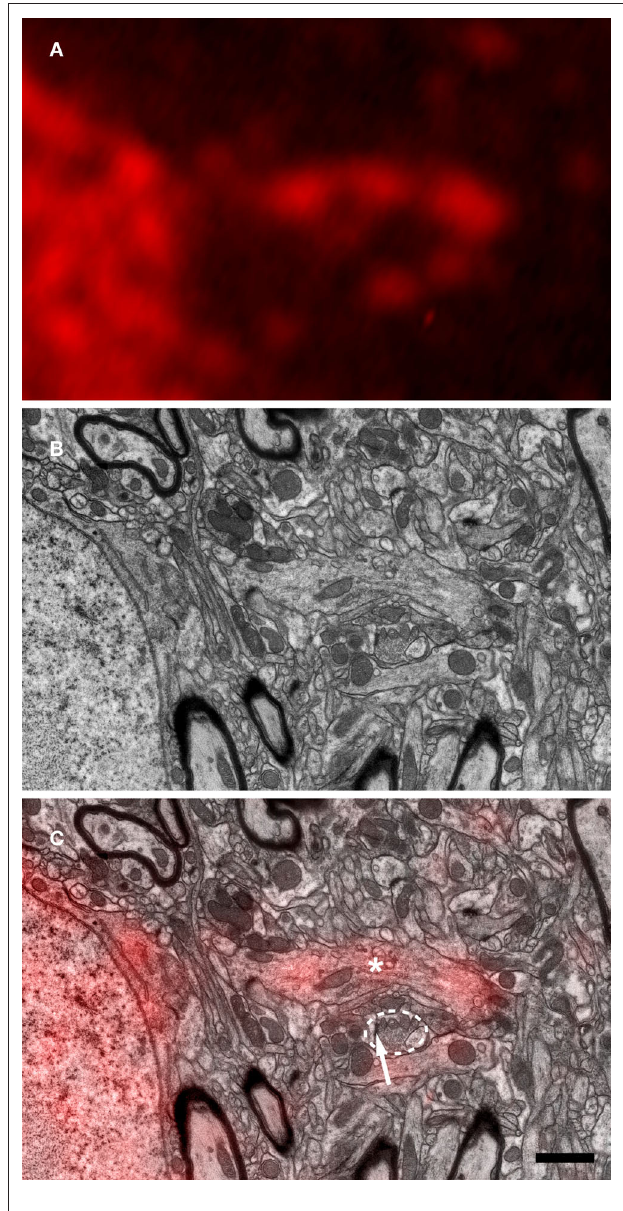
Figure 5 | Magnified view of part of Figure 4. (A) LM image of a dendrite immunostained for Lucifer yellow. (B) TEM micrograph of the same region as in (A) . (C) Superposition of immunofluorescence and TEM images allows classification of the dendrite (asterisk) as belonging to an RA-projecting cell. Synapses are clearly identifiable: an example pre-synaptic terminal is marked by dashed white ellipse; the corresponding post-synaptic density is indicated by the arrow. Scale bar: 1 μm.